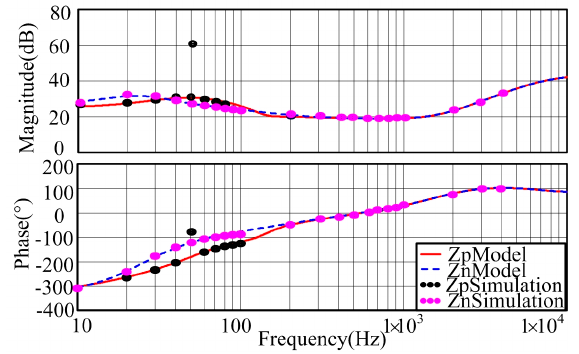
Figure 10. Impedance response with αβ -domain IC control.